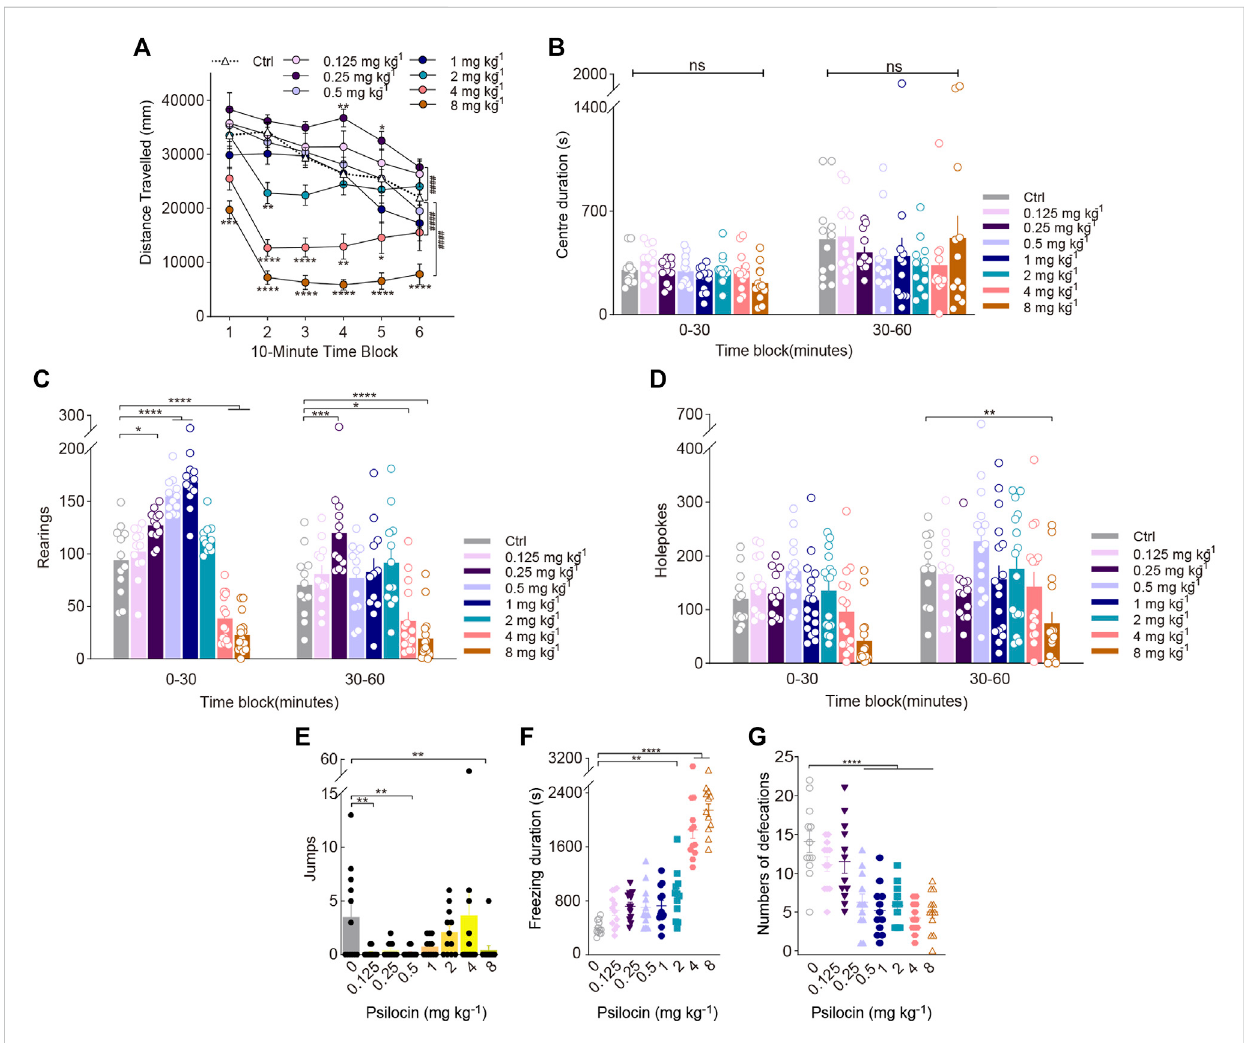
FIGURE 3 Behaviouralchangesinlocomotoractivityandexploratorybehaviourofmiceinducedbytheindoleaminepsychedelicpsilocin.Theeffectofpsilocin on (A) distance travelled (in mm), (B) centre duration (in seconds), (C) the total number of rearing behaviours ( rearings ), (D) the total number of hole explorations ( holepokes ), (E) the total number of jumps ( jumps ), (F) freezing duration (in seconds), and (G) the total number of defecations. Data are shown as the means ± SEM for consecutive 10-min (A) and 30-min intervals (B – D) . n = 12 mice per group. Statistical tests included two-way repeated measures (A) , one-way (F,G) , and two-way (A – D) ANOVA followed by Dunnett ’ s multiple comparisons tests. Kruskal-Wallis H test with Dunn ’ s multiplecomparisonstests (E) comparingtreatmentgroups tothecontrolgroup. * p < 0.05, ** p < 0.01,*** p < 0.001,**** p < 0.0001,and #### p <